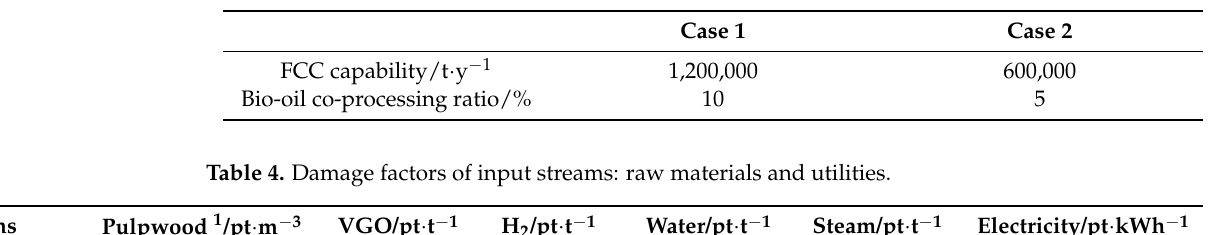
Table 3. Key parameters of Cases 1 and 2.